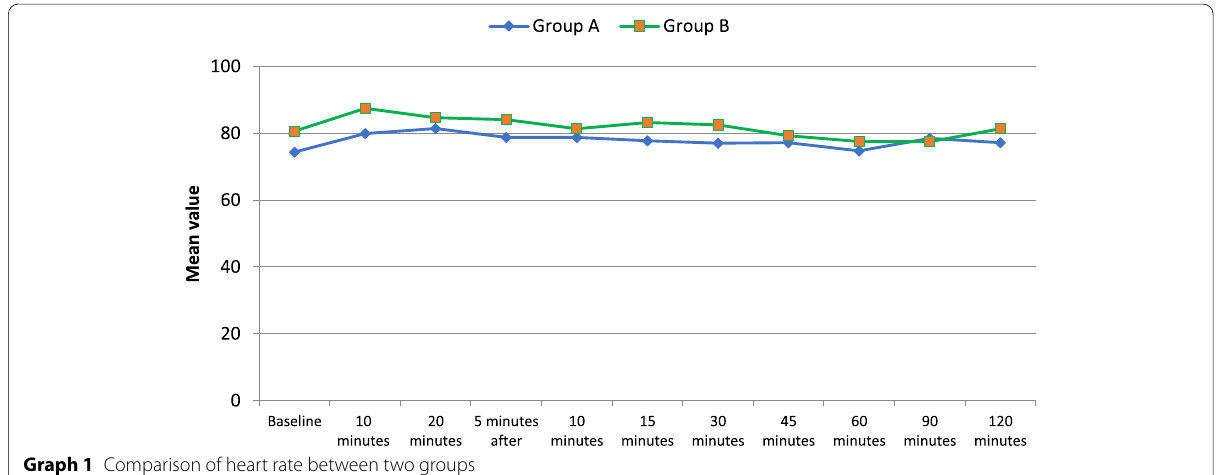
Graph 1 Comparison of heart rate between two groups